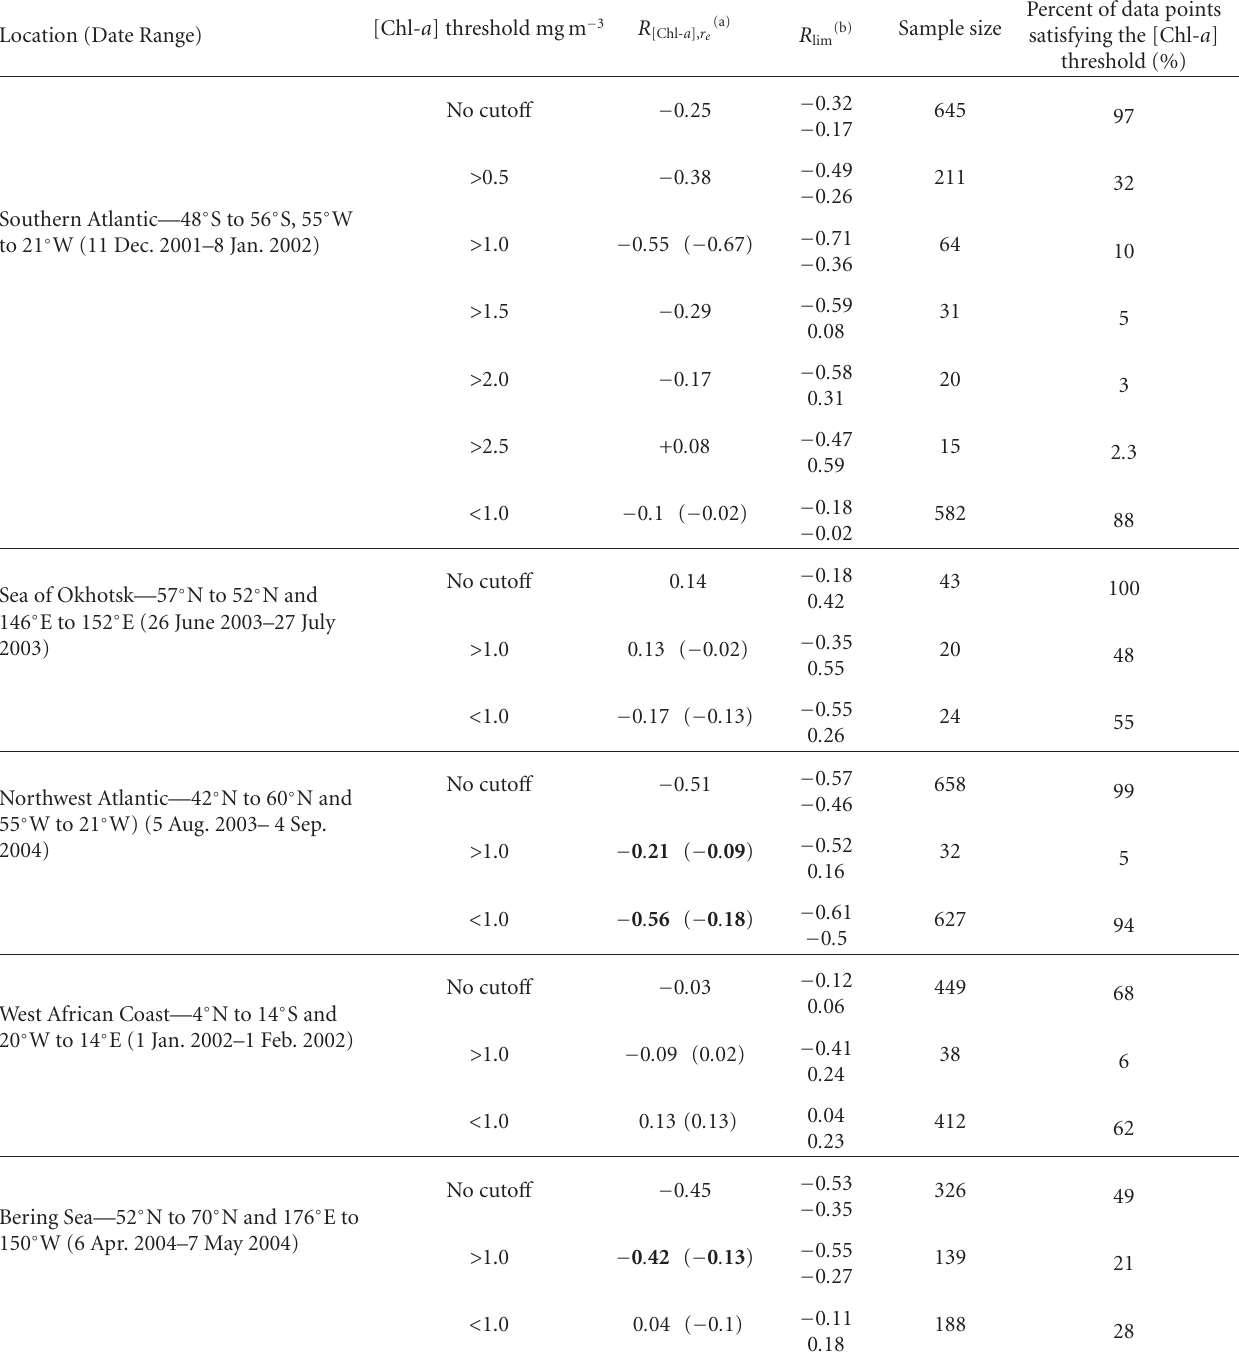
Table 2: Correlations of [Chl- a ] and r e for the events chosen in MY08, using di ff erent threshold values of [Chl- a ] that define the phytoplankton